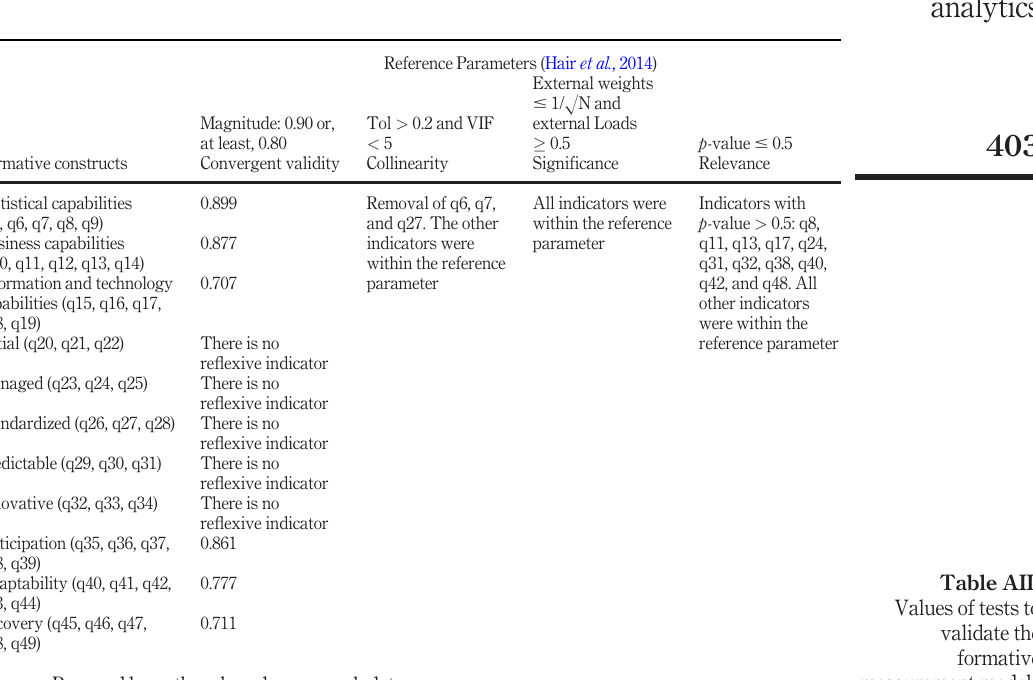
Table AII. Values of tests